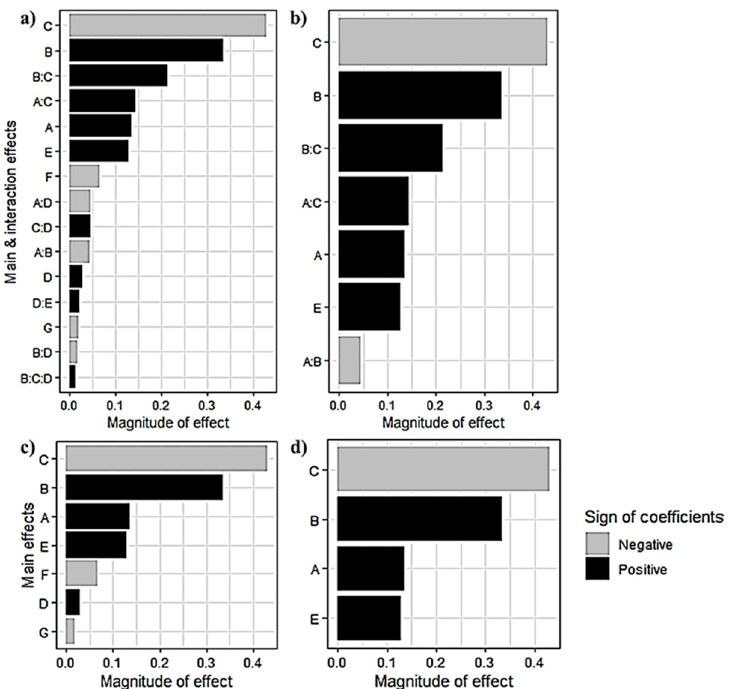
Figure 5. Pareto plots for thermoacoustic efficiency FFD of resolution IV. ( a ) shows the main and interaction effect: for all factors; ( b ) shows the same but removing the negligible F, D and G factors; ( c ) only the main factor effect display for all factors; and ( d ) the same, but removing the negligible F, D, and G factors.